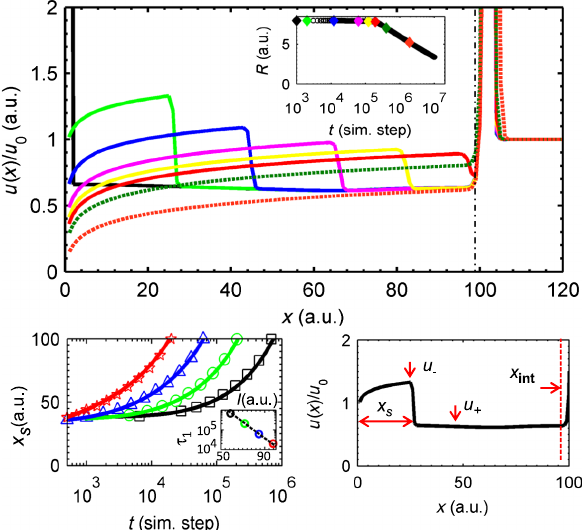
FIG. 3. Top panel: Snap shots of the time evolution of the density profile u ð t; x Þ within the active interfacial region in a simulation of the VEOVM model (see Appendixes C and D for ¼ 1000 and details). The current used is I ½ a : u : (cid:2) ¼ 71 . 5 , with A SB ¼ 1 . where a.u. stands for arbitrary units in all corresponding A B figures. The time steps of the successive profiles can be read off from the corresponding color dots in the inset. The initial state u ð 0 ; x Þ (black line) exhibits a vacancy pileup next to the electrode at x ¼ 1 . The SB-bulk interface is denoted with a vertical dash- ¼ 100 . The large accumulation of vacancies on the dot line at x int right of x (bulk side) results from the initial “ forming ” cycles int performed on an originally uniform profile of density u 0 . The result of the forming cycles is an approximately fixed background on top of which the density profile further evolves (see details in Ref. [27]). Inset: Resistance of the device as a function of time. Color dots indicate the value of R ð t Þ at the corresponding snapshots of the main panel. Bottom-left panel: Evolution of ð t Þ for different currents the shock-wave front position x s ( I ½ a : u (cid:2) ¼ 58 . 5 , 71.5, 84.5, and 97.5). Dots are from numerical simulations, and the solid lines are analytic fits from integration of Eq. (4). Inset: Characteristic impact time τ 1 as a function of applied currents from the numerical simulation (circles) and analytic fit (dotted line) in semilog scale. Bottom-right panel: Shock-wave panel) for different values of the electronic current I . We